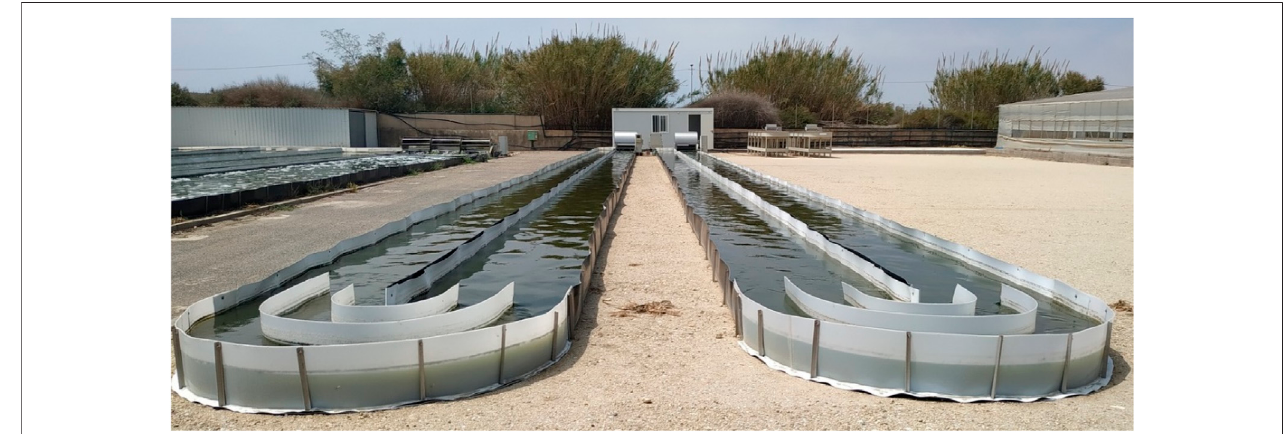
FIGURE 2 | Raceway reactor. The real input data for simulating the seasons of the year were collected from the sensor located in